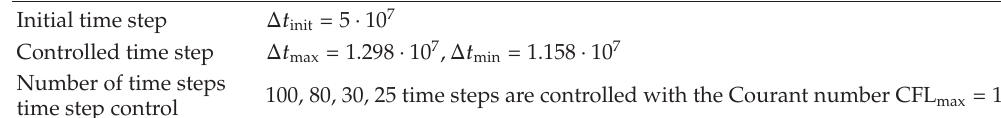
Table 10: Spatial discretization parameters.